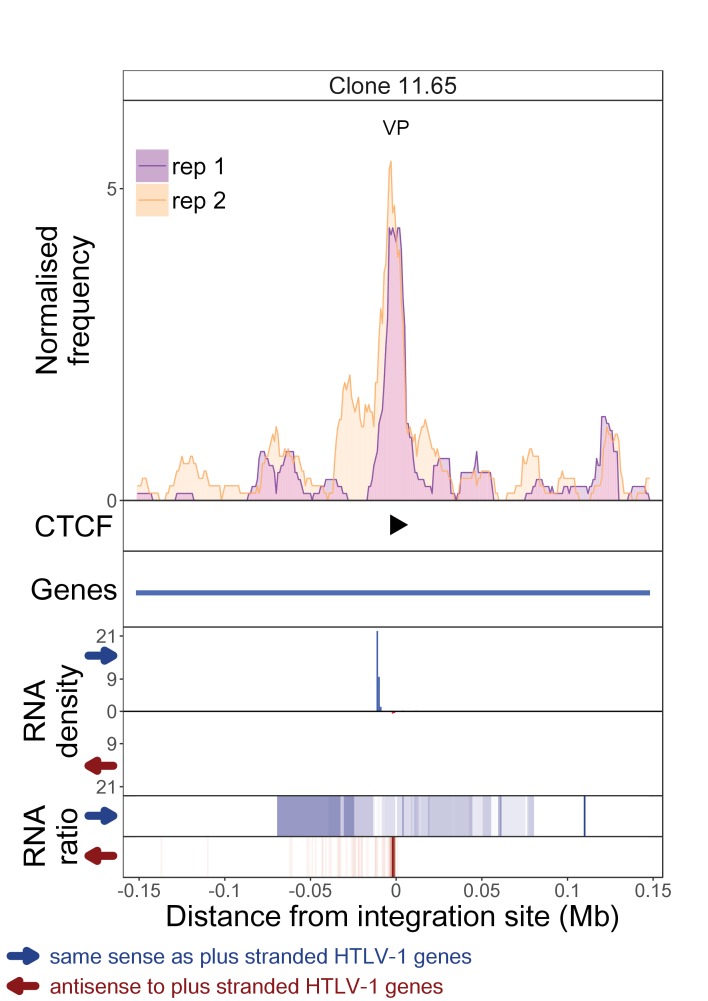
q4C and RNASeq data aligned – clone 11.65. See legend for Figure 1—figure supplement 1.